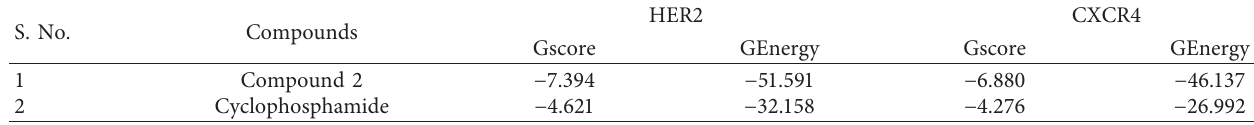
Table 2: Glide scores and Glide energies of CXCR4 and HER2 target proteins and ligands. S. No.